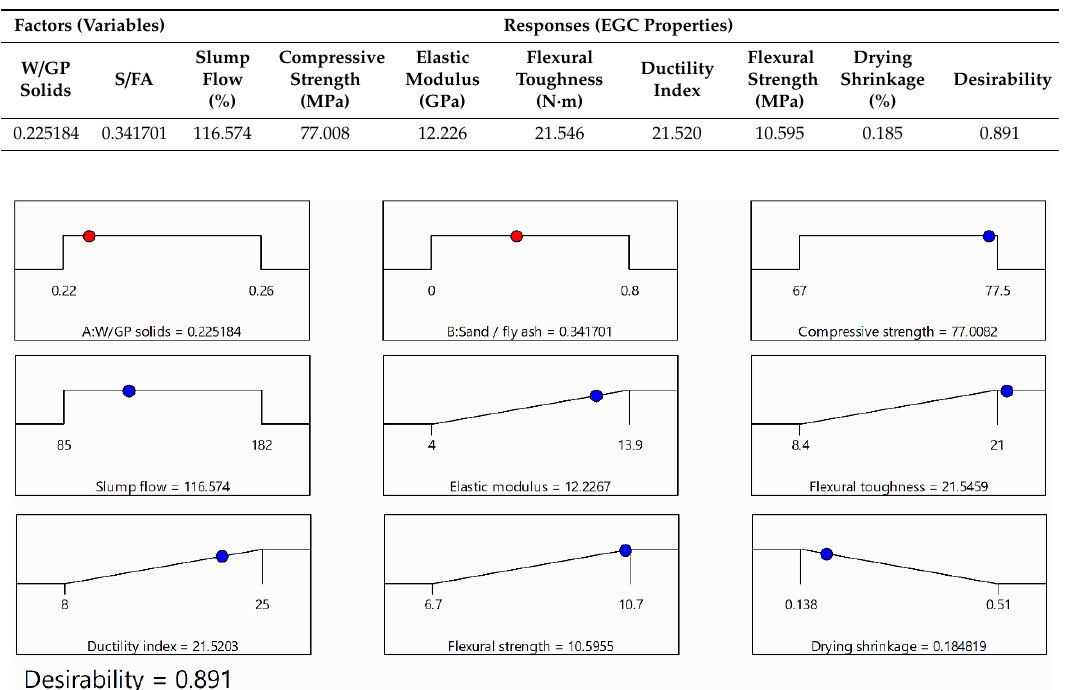
Table 11. Optimized solutions with desirability.